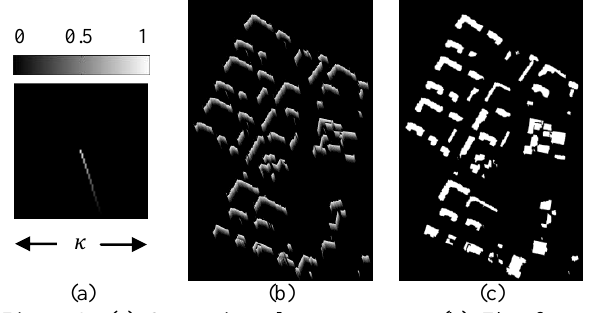
Figure 2. (a) Structuring element . (b) The fuzzy landscapes generated using the shadow mask provided in Fig. 1c, and (c) building regions detected after Stage I.